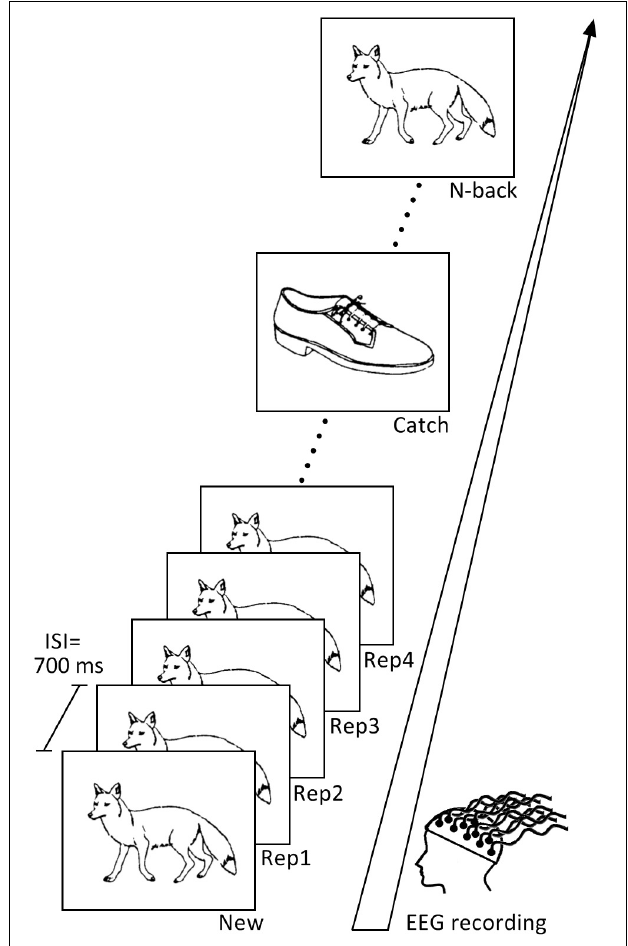
FIGURE 1 | Continuous recognition task design. The learning task consisted of two blocks containing different set of pictures. Subjects had to indicate if the presented picture is new (New) or repeated. Pictures were repeated up to four consecutive times (Rep1, Rep2, Rep3, Rep4) and then re-appeared after 9–15 intervening items (N-Back). Pictures presented only once in the sequence (Catch) were inserted in order to avoid the habituation to the